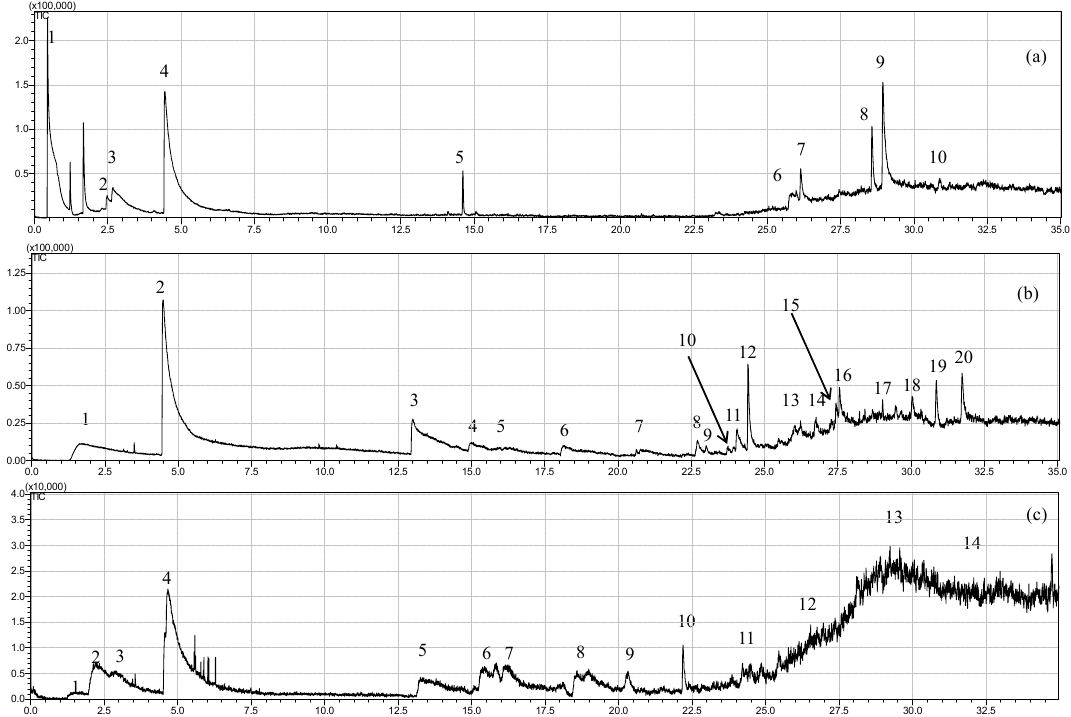
Figure 12. Py-GC / MS pyrograms P(ESES)-co-(ESDPA) 50:50 copolymer recorded at ( a ) 400, ( b ) 500 and ( c ) 600 °C.